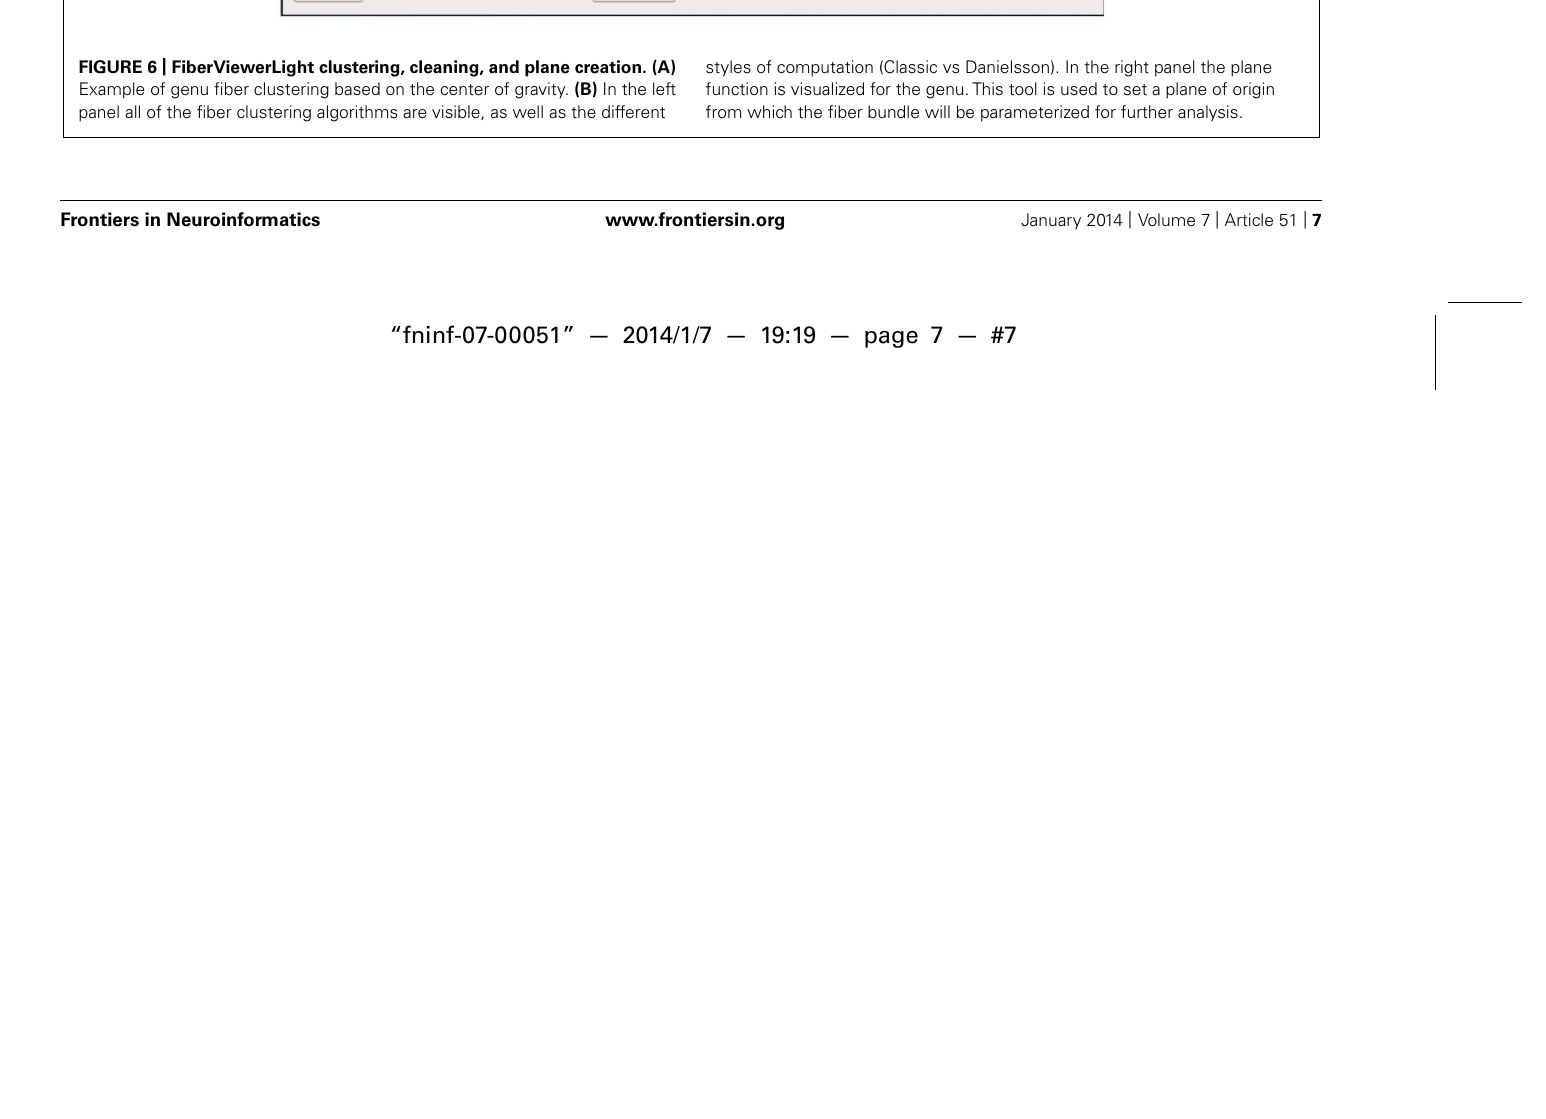
styles of computation (Classic vs Danielsson). In the right panel the plane function is visualized for the genu.This tool is used to set a plane of origin from which the fiber bundle will be parameterized for further